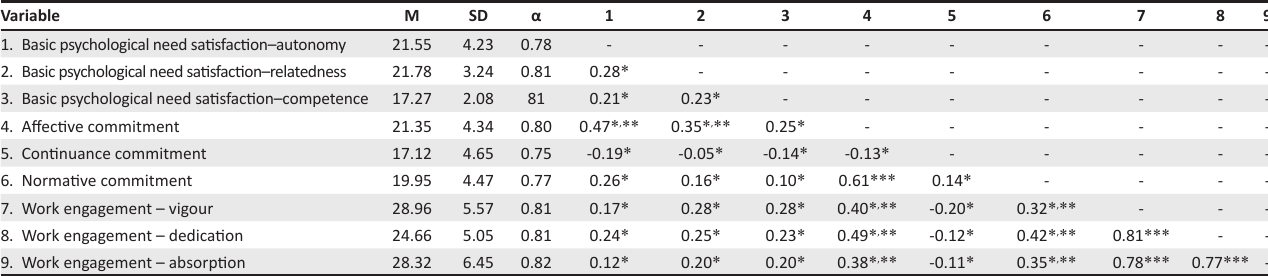
TABLE 2: Descriptive statistics and Pearson correlation coefficient. Variable